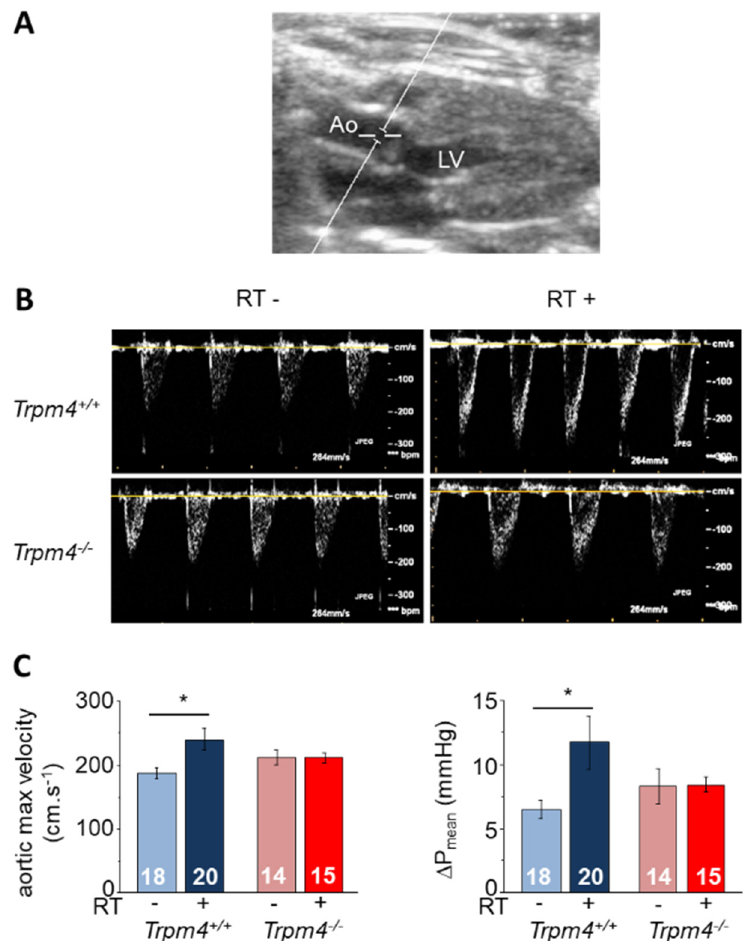
Figure 2. Functional valvular remodeling 5 months after radiation treatment. ( A , B ) Examples of transthoracic echocardiography in the Doppler mode for Trpm4 +/+ and Trpm4 − / − without (RT − ) or with (RT+) irradiation at 5 months post-treatment on anesthetized 9-month-old male mice. Measurements were made at the aortic valve level to reveal aortic flux velocity. The image provided in A allows to visualize where the measurements were taken. LV (left ventricle); Ao (aorta). ( C ) Mean maximal aortic valve jet velocity ( left ) and mean pressure gradient ( Δ P mean ) ( right ) for each group according to the echocardiography. Data are expressed as mean ± S.E.M. * indicates a significant difference between groups ( p < 0.05).